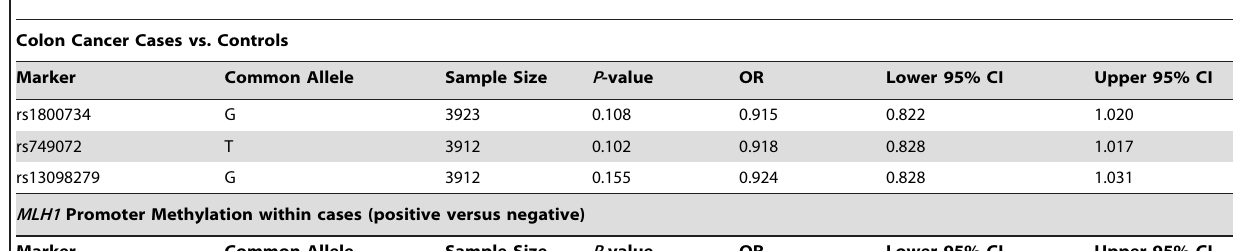
Colon Cancer Cases vs.